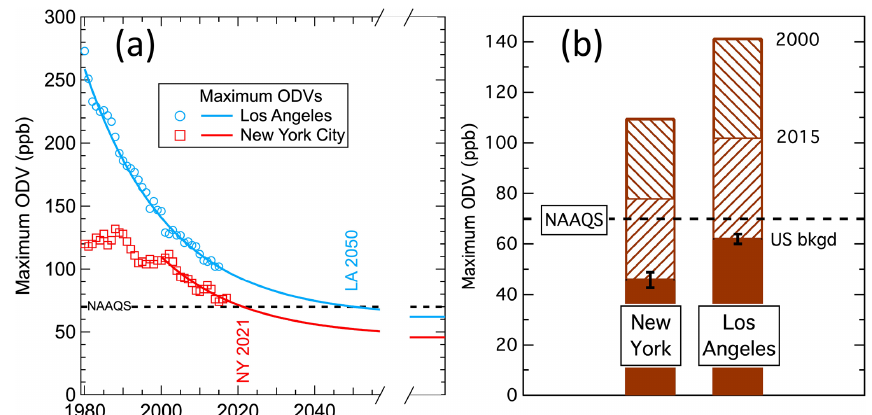
Figure 11. Comparison of maximum observed ODVs in the New York City and Los Angeles urban areas. (a) Temporal trend of observations (symbols) and fit to Eq. (1), including extrapolation to infinite time; annotations indicate year that extrapolations decrease to 70ppb. The New York City results are the maxima from either the states of New York or New Jersey, and the Los Angeles results are those for the South Coast Air Basin (Fig. 8 of Parrish et al., 2017a). (b) Bar graph indicating maximum ODVs in 2000 and 2015 (hatched bars) and the estimated US background (bkgd) ODV (solid bars); the maximum ODVs are derived from the fits to Eq. (1) included in (a) .